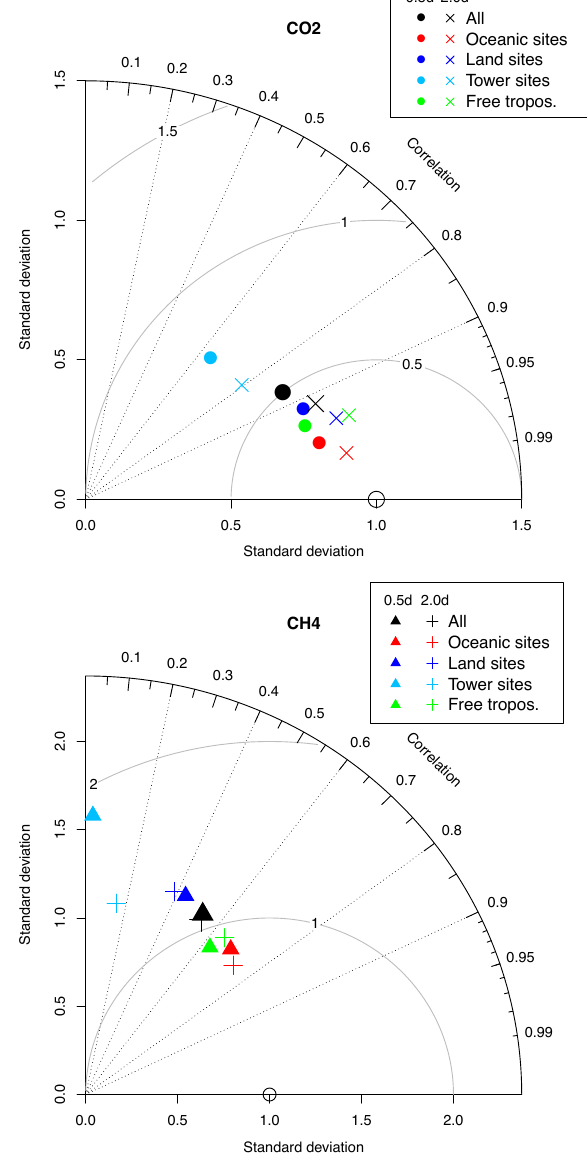
Fig. 5. Normalised Taylor diagram showing a statistical compari- son (Pearson’s correlation coefficient, normalised standard devia- tion, and centred root-mean-square difference) between simulated CO 2 (top) and CH 4 (bottom), and GV analysis, for monthly sea- sonal variations. “0.5d” and “2.0d” in legends indicate 0.5-degree simulation and 2.0-degree simulation,